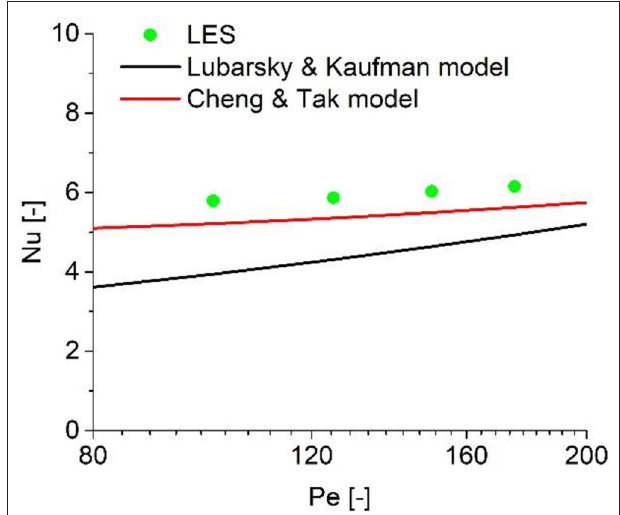
FIGURE 6 | Nusselt number as a function of Peclet